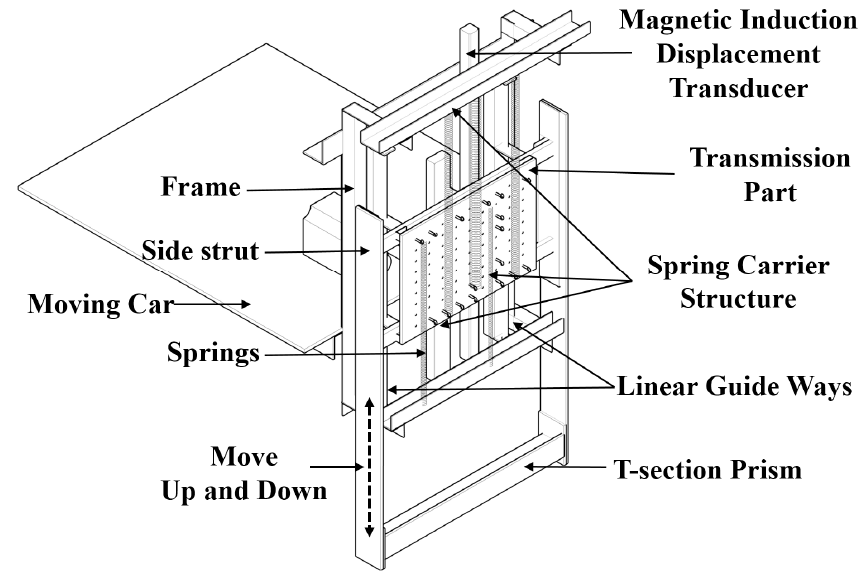
Figure 3. Test apparatus.